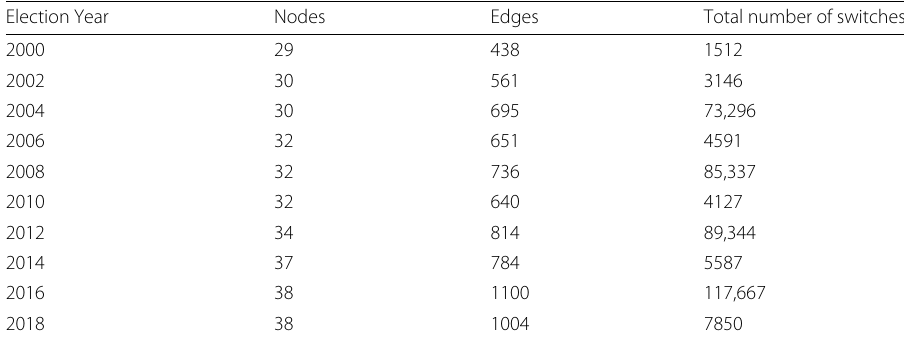
2018 38 1004 7850